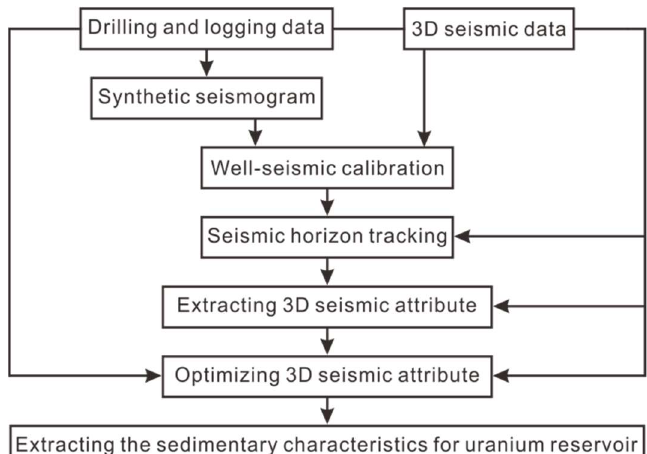
Figure 1. The workflow of extracting the sedimentary characteristics for uranium reservoir.